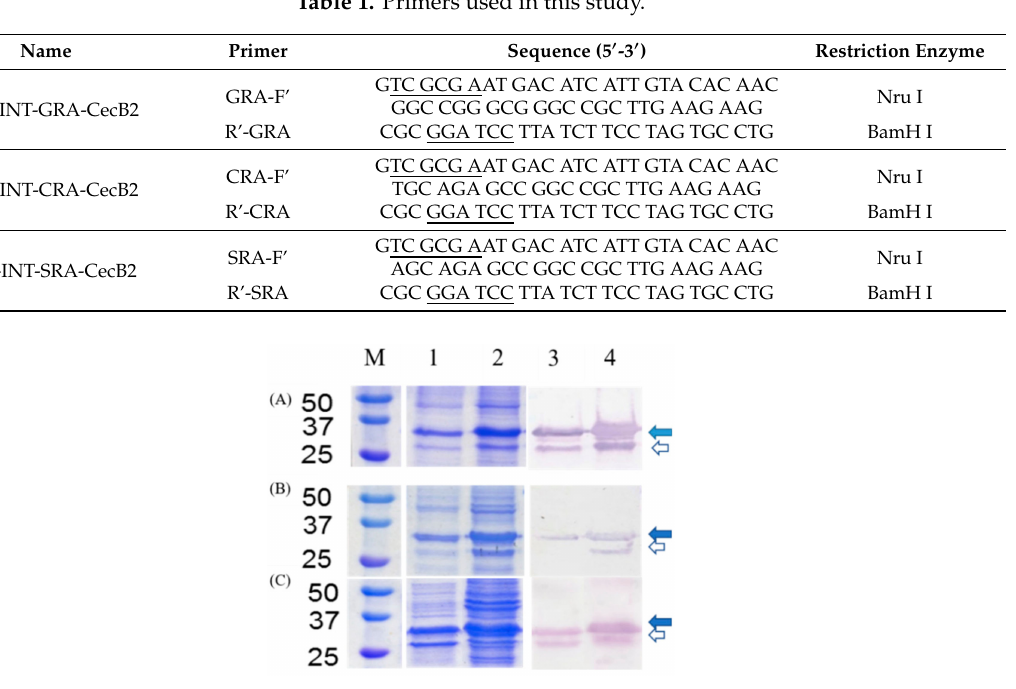
Figure 1. SDS-PAGE and Western blot analysis of pTWIN1-chitin-binding domain (CBD)-intein (INT)-oligopeptide cleavage variants (OCV)-cecropin B2 (CecB2): Lane M: marker (kDa), Lane